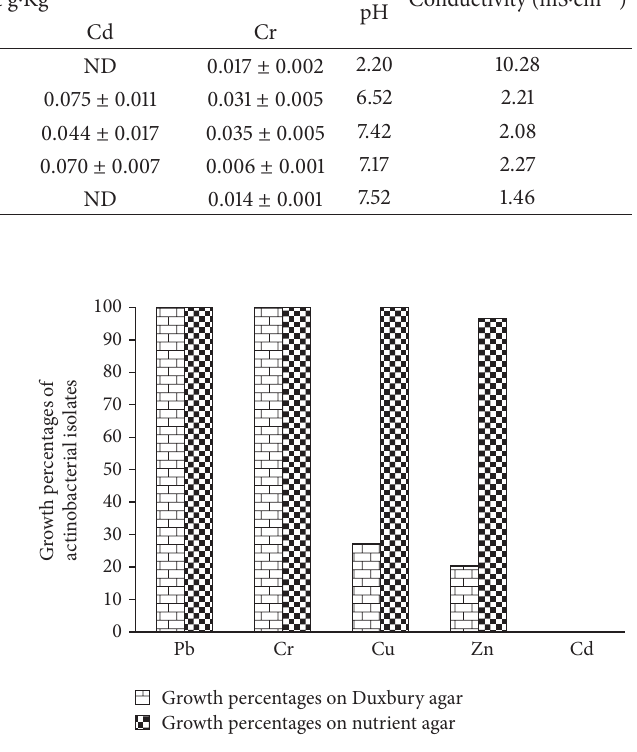
Table 1: Mean heavy metal concentrations, pH, and conductivity in mining residues samples. Mining areas